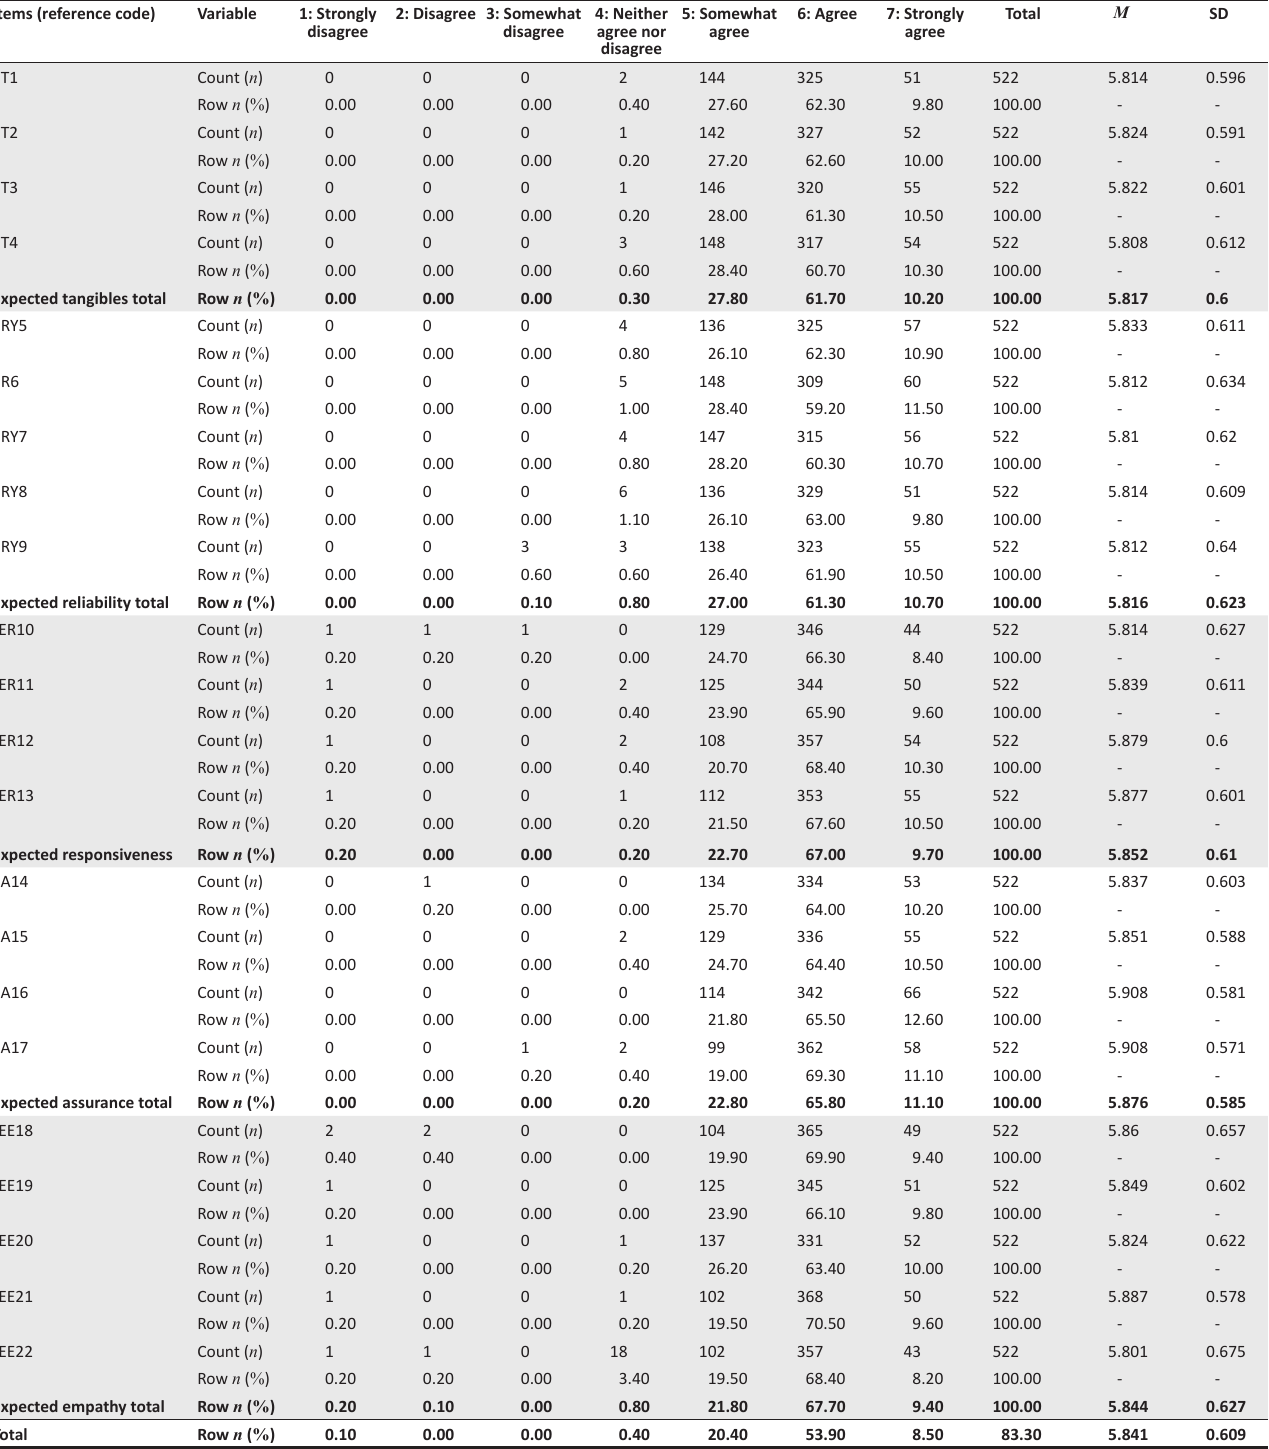
TABLE 2: Results on service quality